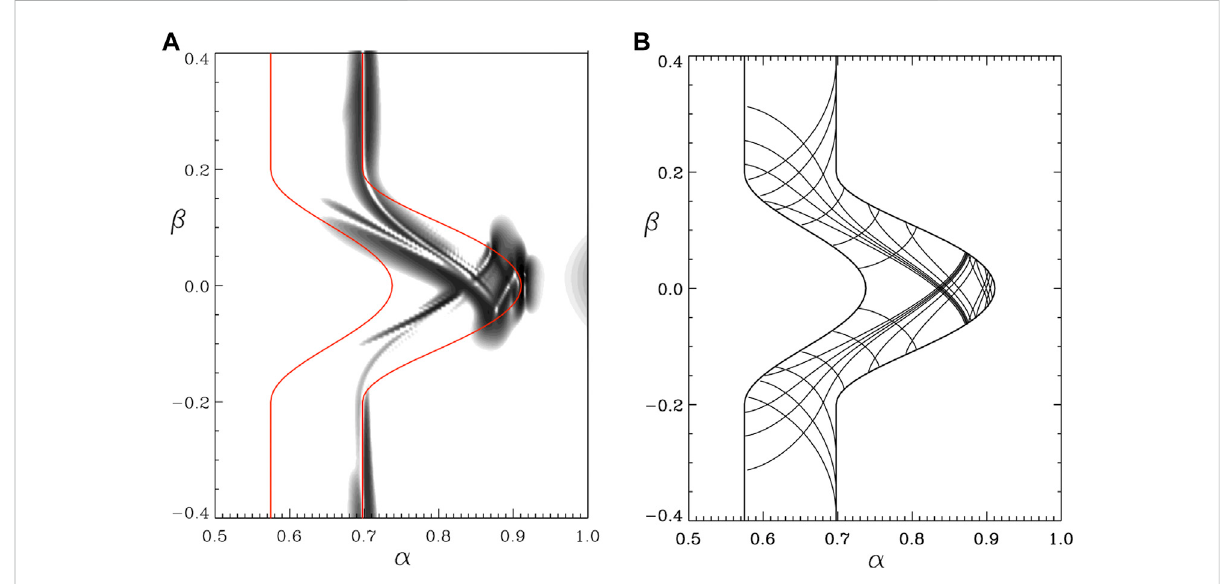
FIGURE 4 Figure 10 from Wright and Elsden (2016). (A) Shaded surface of the total energy density in the equatorial plane. Red lines are the boundaries of the Resonant Zone. (B) Resonance Map for simulation equilibrium and chosen driving